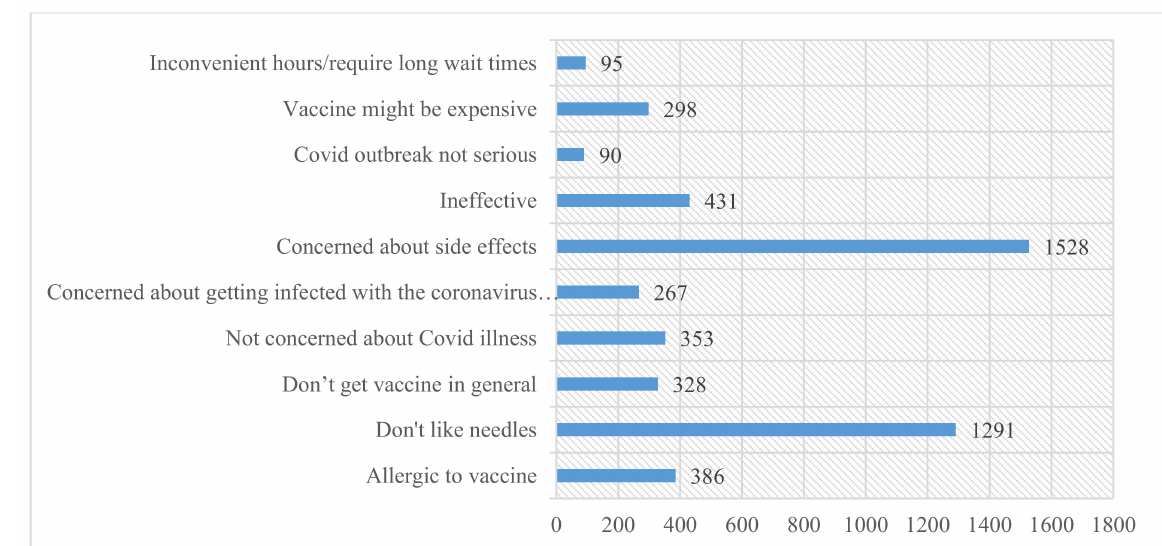
Figure 2. Factors associated with vaccine